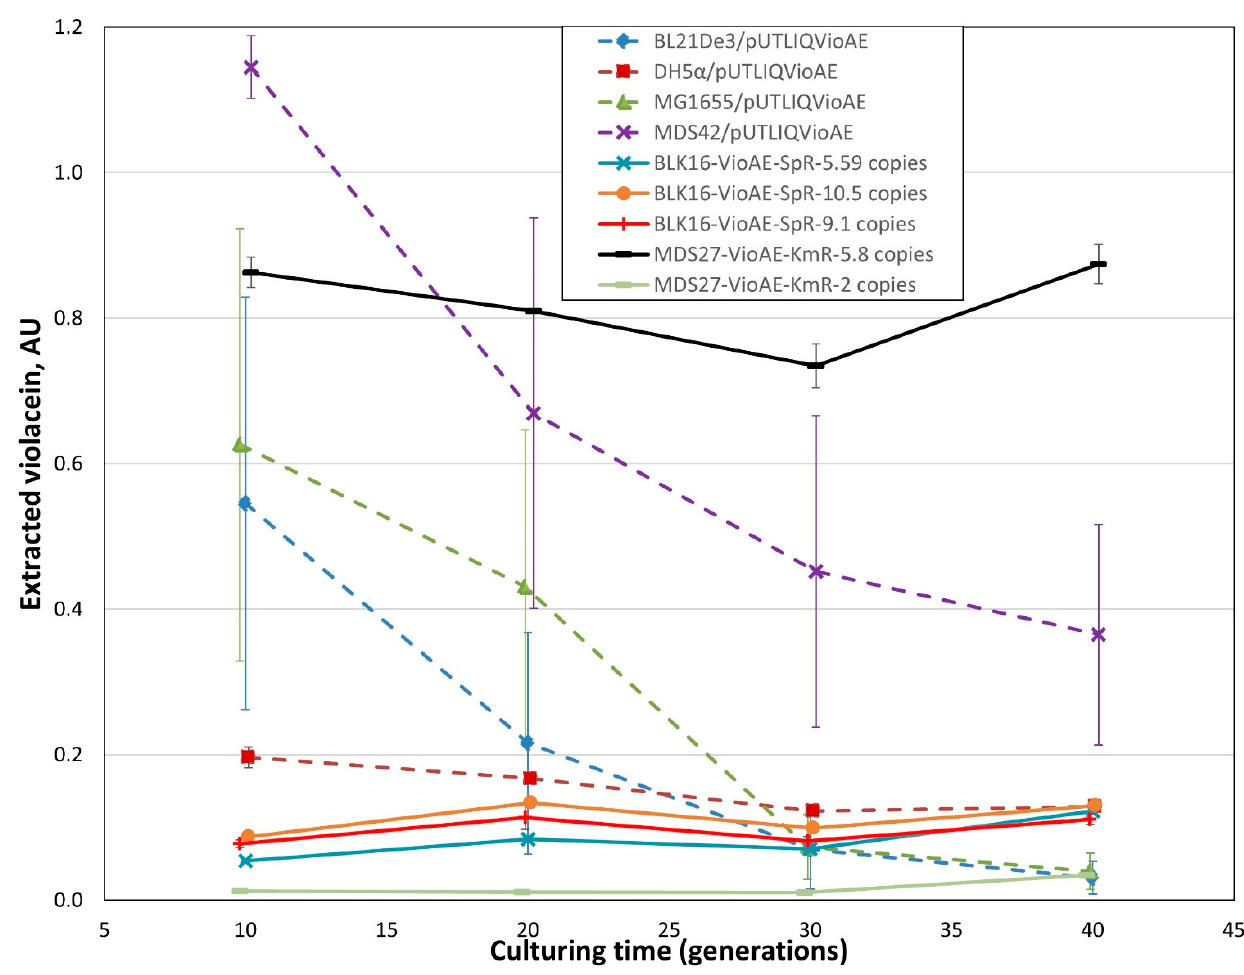
Figure 9. Violacein levels of liquid bacterial cultures grown in the lack of antibiotic selection. Dashed lines mark strains carrying plasmid pUTLIQ_ vioABCDE , solid lines mark strains carrying an IS3:: vioABCDE cassette on their chromosomes, as indicated in the legend. All values are means of three biological replicates. Error bars mark the standard error of the mean. The statistical analysis of the violacein content measured at generation 40 is shown in Figure S17 of the Supplementary Materials.